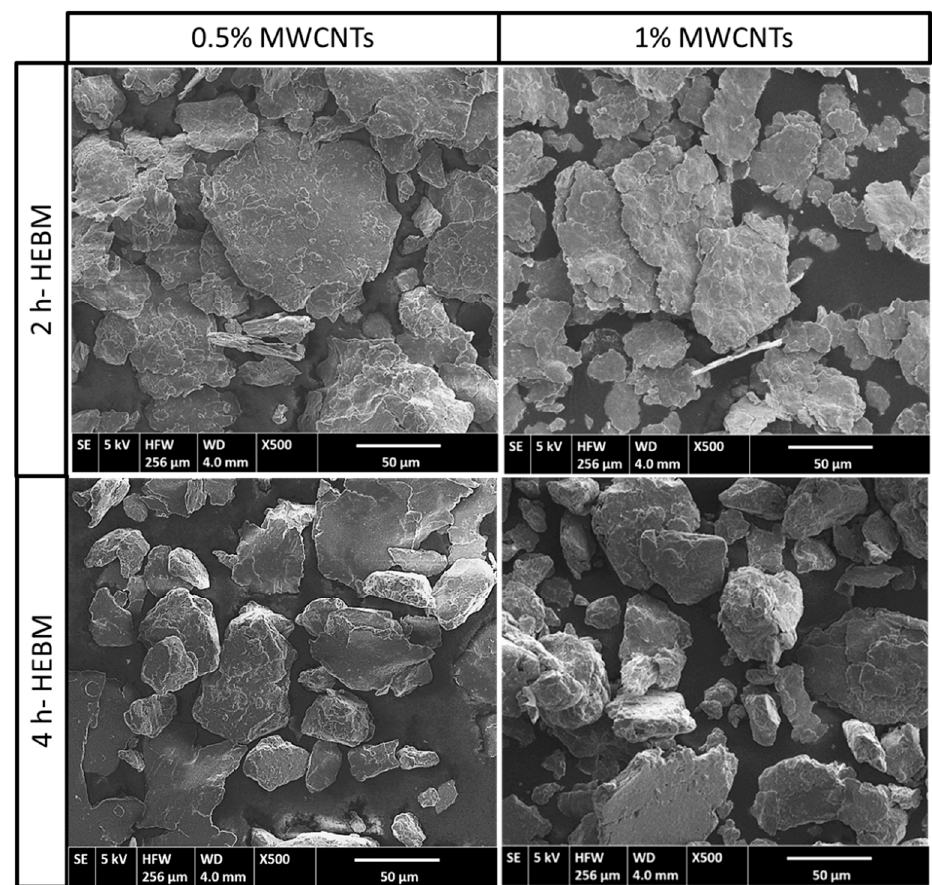
Figure 5. SEM morphological evolution of MWCNT composite powders after 2 h and 4 h of HEBM.